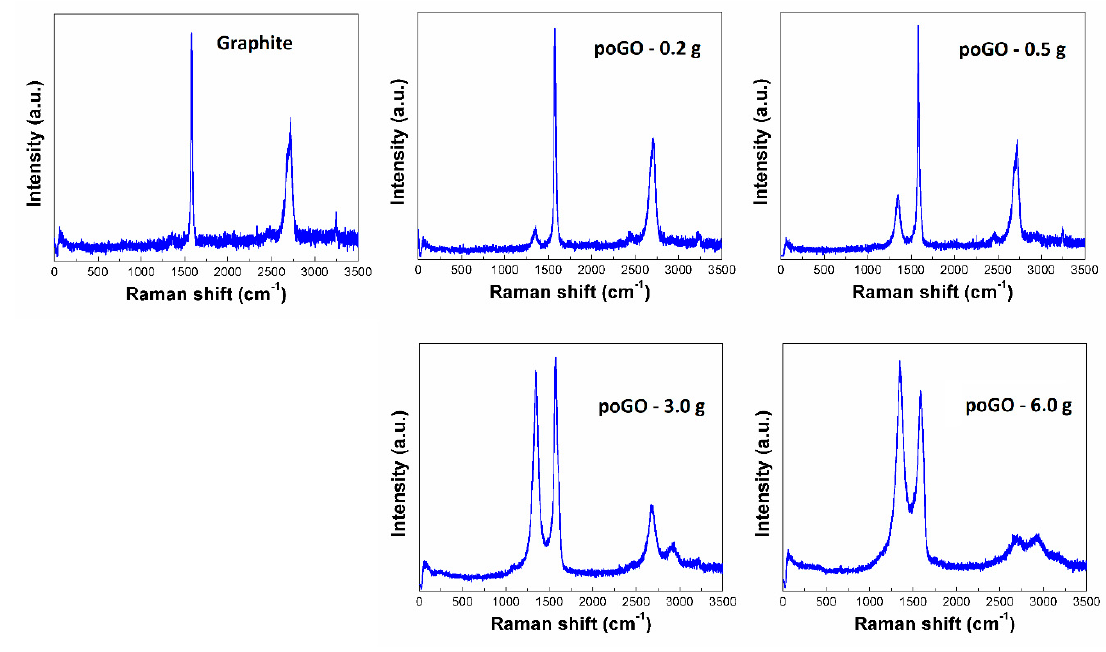
Figure 4. Raman spectra of poGOs.